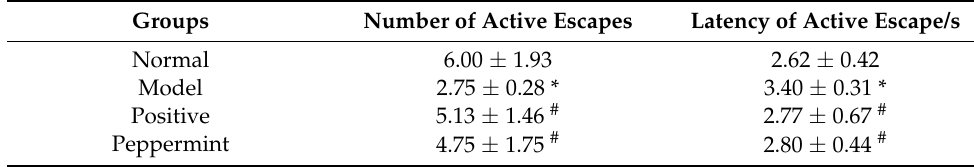
Table 3. Results of shuttle box test (x ± S, n =